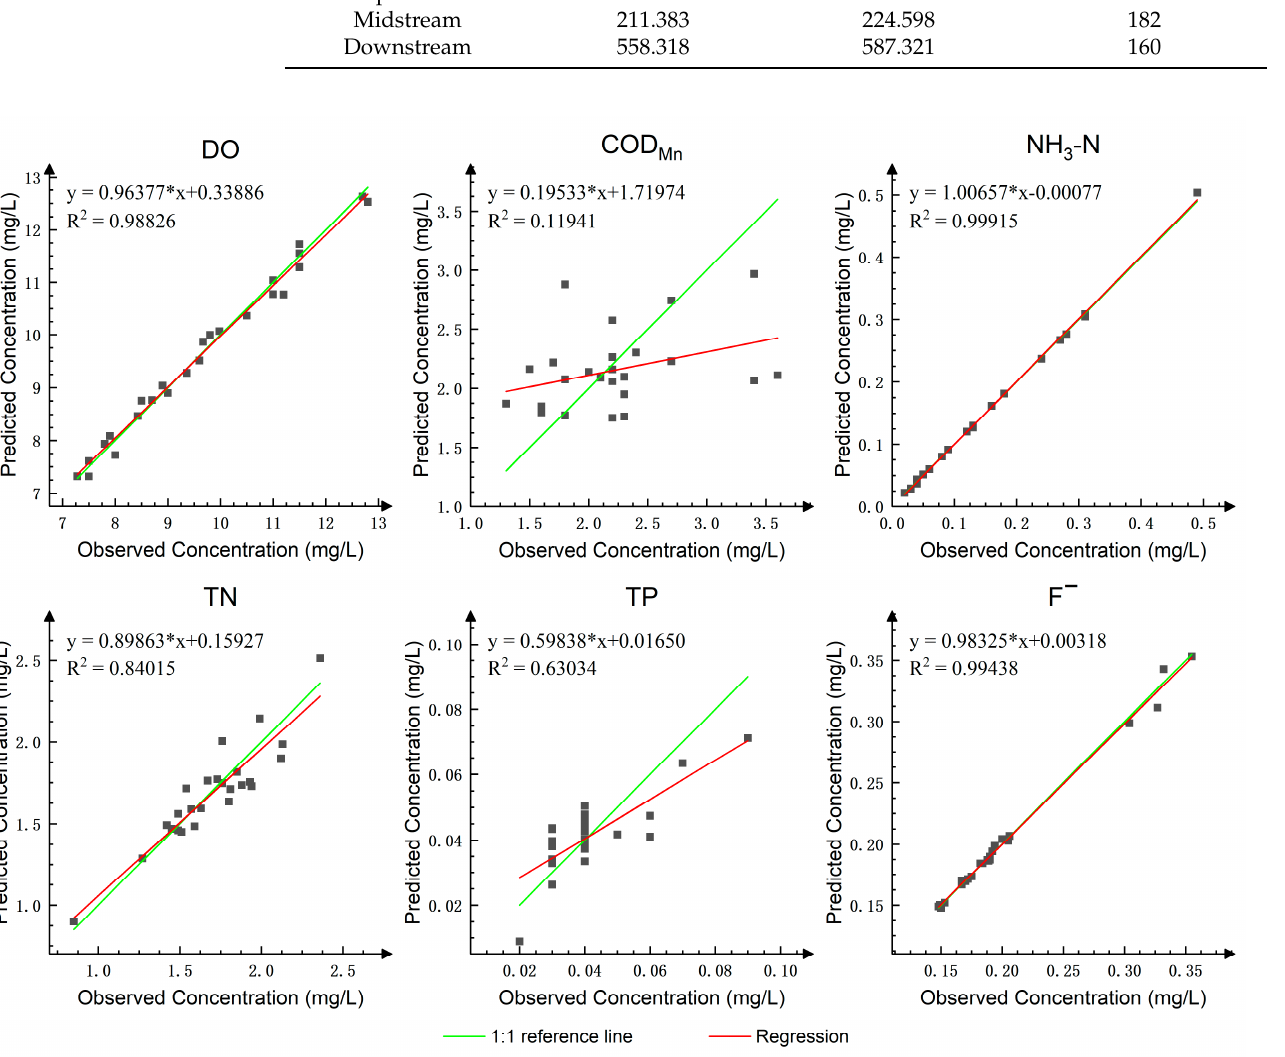
Table 6. Operation parameters in upstream, midstream, and downstream.